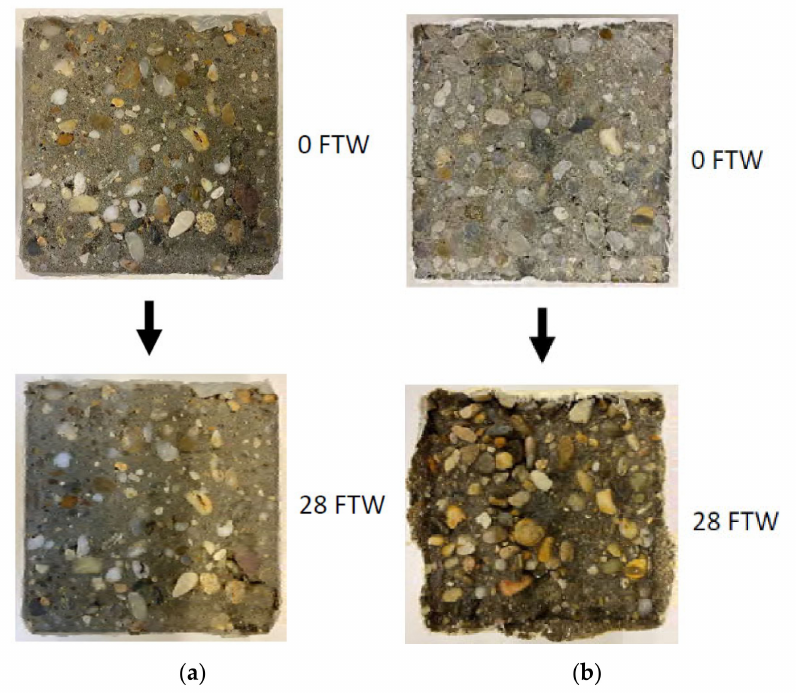
Figure 10. Weathering impact of 28 freeze–thaw cycles with defrosting salt: low weathering of the concrete XC4/XW2/XD3/XF4/XA1L ( a ), high weathering of the concrete XC2 ( b ); FTW = number of freeze–thaw cycles.